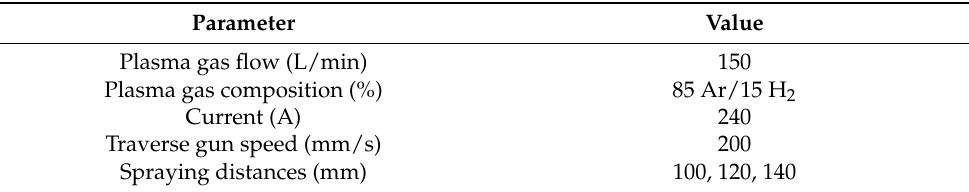
Table 1. Plasma spraying parameters.